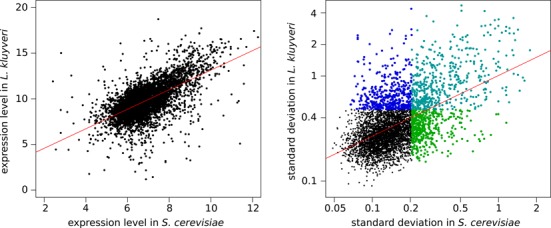
Comparison of transcription level (left) and variation (right) between L. kluyveri and S. cerevisiae orthologs. The transcription levels correspond to the mean of the transcript abundance across all isolates of each species. Colors on the variation plot correspond to the sets of genes we used for enrichment in order to identify the difference in transcription between L. kluyveri and S. cerevisiae. The standard deviation axes are in a log scale.